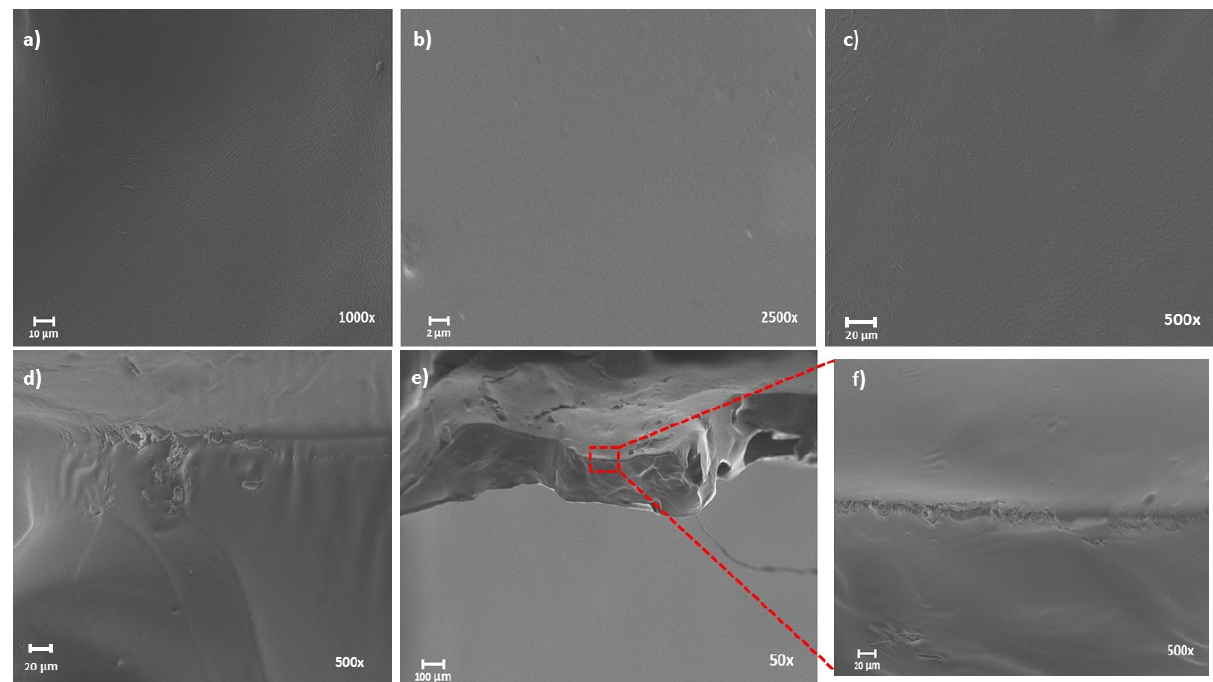
Figure 3. SEM images of cellulose films: ( a ) top view, Ac110, ×1.0 K; ( b ) Pr130, ×2.5 K; ( c ) Ac130, ×500; cross sections view, ( d ) Pr110, ×500; ( e ) Ac90, ×50; ( f ) Ac90, ×500.